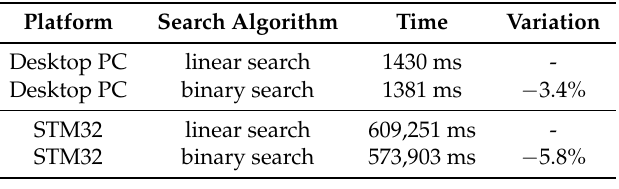
Table 8. Execution time of the genetic algorithm.